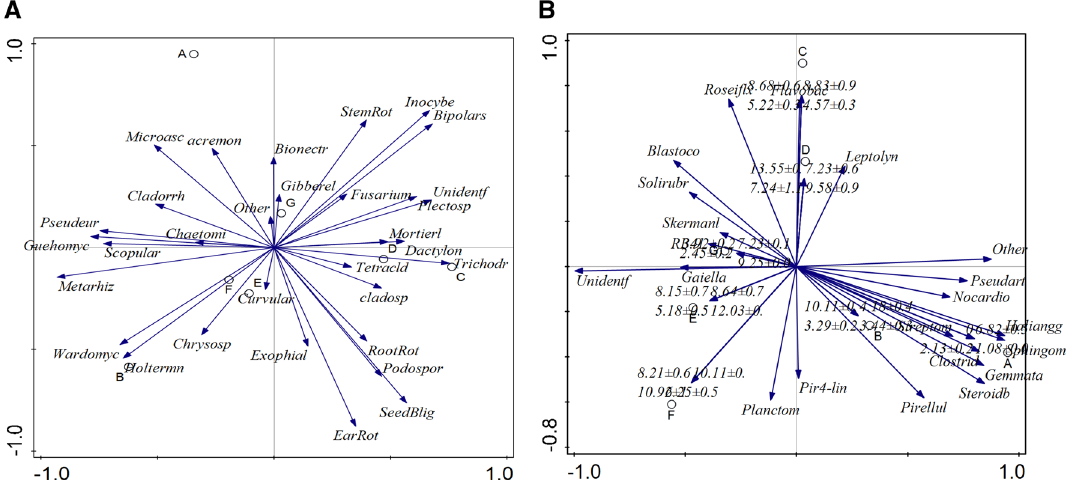
Figure 7. ( A ) RDA analysis of the relationship between the disease incidence and relative abundance of fungal genus of different cropping years. Correlation between different disease incidence and RDA axes were represent by the length and angel of arrows. ( B ) RDA analysis of the relationship between the disease incidence of different continuous cropping year and relative abundance of bacteria genus of different cropping years. Correlation between different disease incidence and RDA axes were represent by the length and angel of disease control and plant production. PCoA results showed that the samples of the same land use types were often clustered but 30 years cropping with field maize were independent with the other years cropping. RDA analysis also confirmed a closely correlation of plant–microbe between the different disease incidence and microbial com- munity structure and diversity in our study. Our results indicated that optimizing the soil microbial community under factors matric to an appropriate level was urgently needed to keep the plantation healthy.